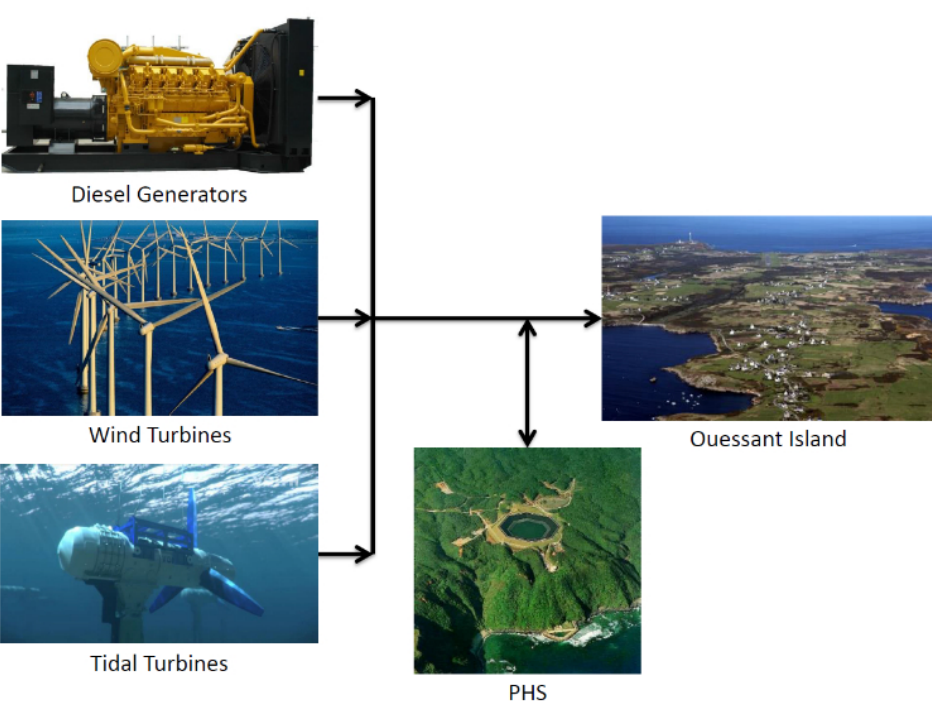
Figure 14. Hybrid energy system for the supply of the island of Ushant proposed in